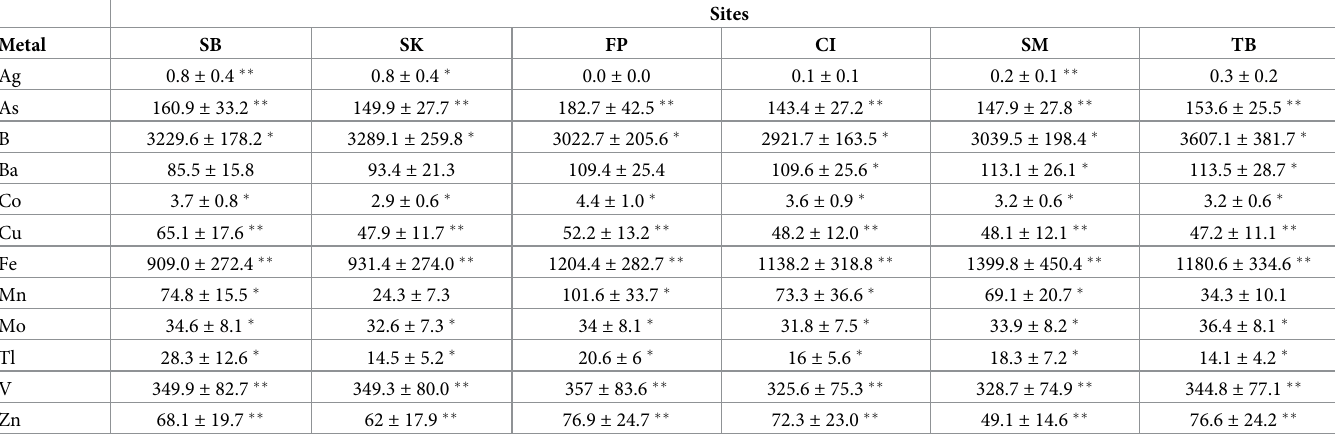
Table 2. Mean metal concentration (mg/L) in water of salt marsh sites.